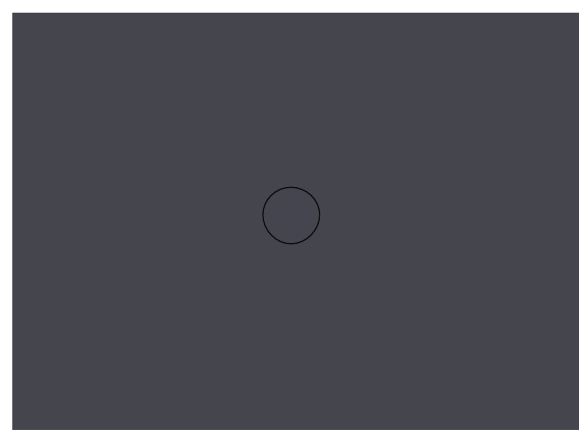
Figure 2: Participants located the stylus inside the central circle, and then the stylus’s visual representation (a stick; see Figures 2– 5) disappeared. Thus, participants could not see their hand or its